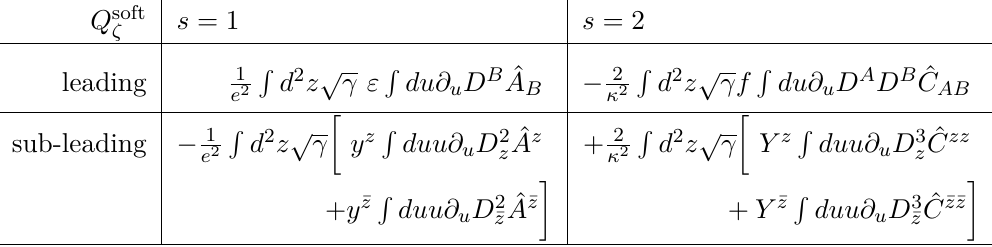
Table 1. Soft charge operators for ζ = { ε, f, y A , Y A } where A = { z, ¯ z }